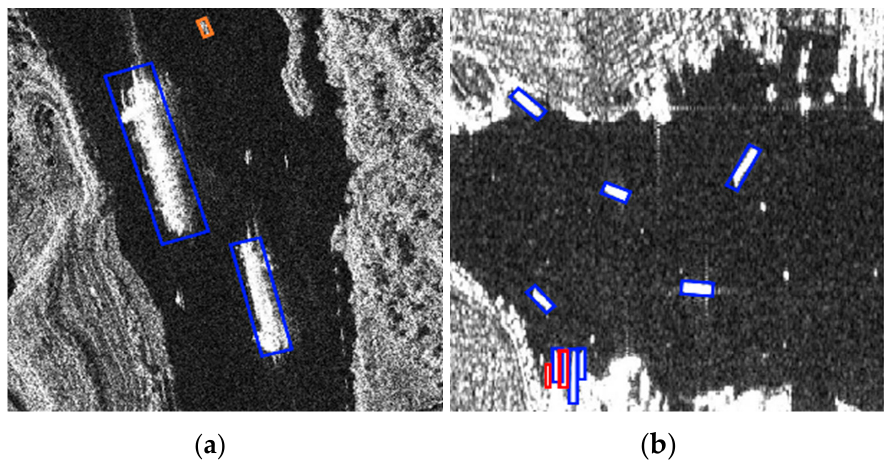
Figure 13. ( a , b ) Undesired results in the SSDD. Blue bounding box means ships that were detected, red bounding box means ships that were missed, and orange bounding box means false alarms.